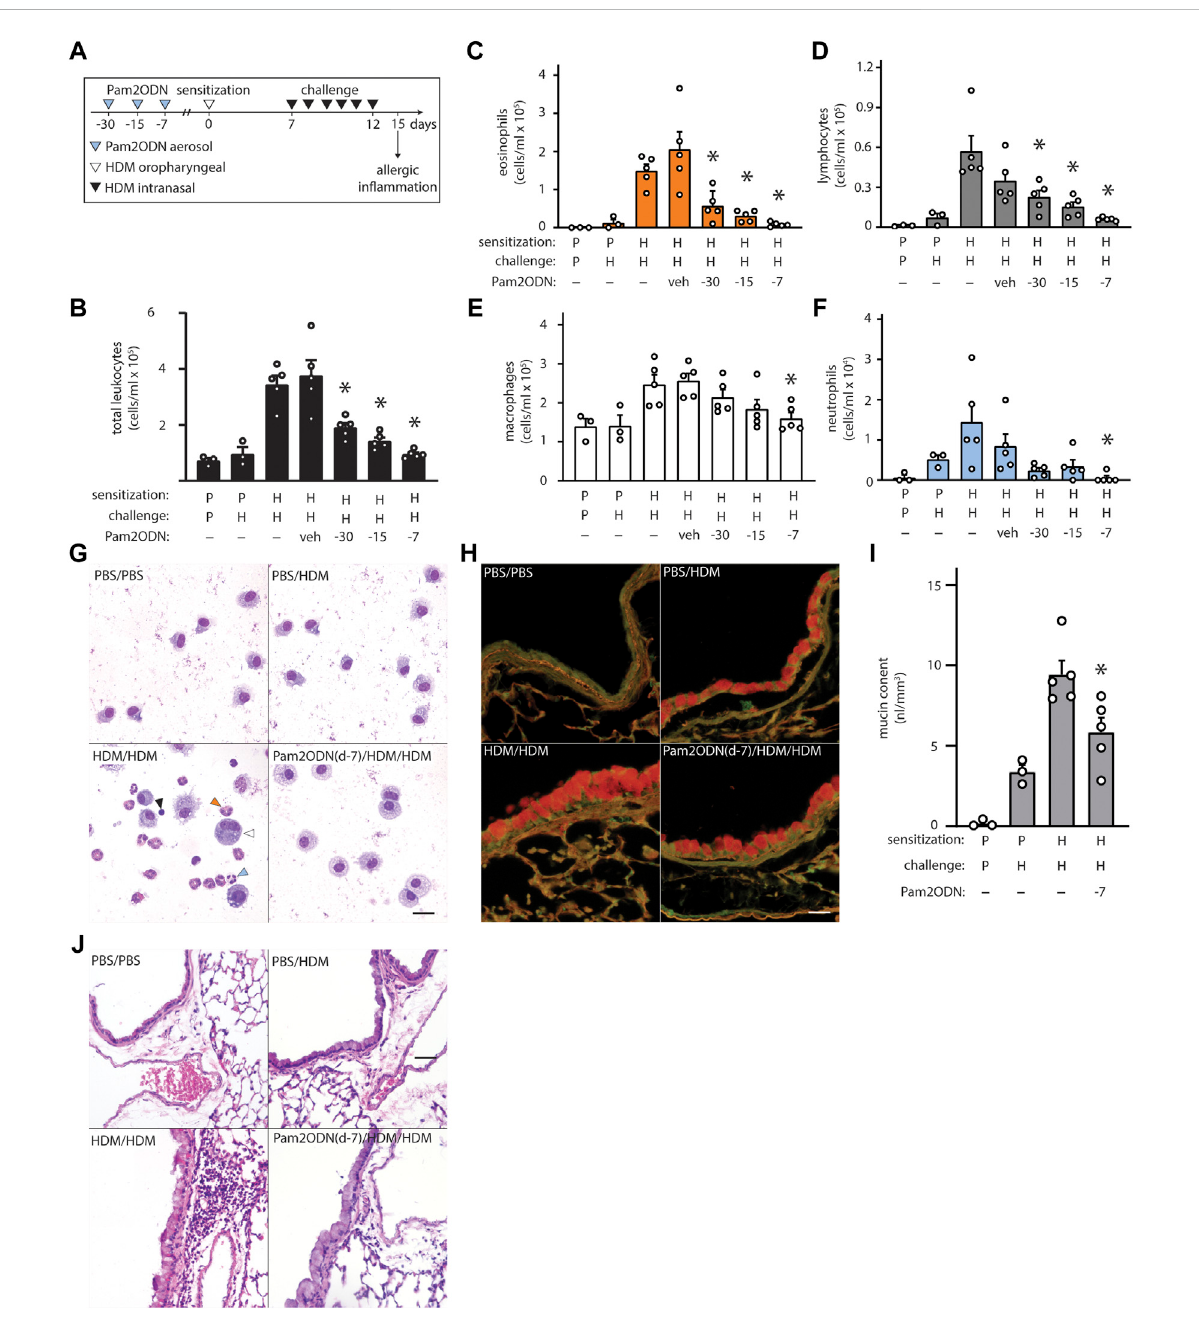
FIGURE 1 Exposure to Pam2-ODN attenuates allergic in fl ammation to HDM. (A) HDM experimental paradigm with a sensitization of 100 µg HDM and challenges of 10 µg HDM. In these studies, a single treatment of Pam2ODN was delivered by aerosol as described, 30-, 15-, and 7-days before initial HDM sensitization to naïve mice. (B) Leukocytes obtained by lung lavage were pelleted onto glass slides by centrifugation and stained with Wright- Giemsa. Scale bar = 20 μ m. (C – F) Quanti fi cation of leukocytes in lung lavage for (C) eosinophils, (D) lymphocytes, (E) macrophages, and (F) neutrophils (N = 3-5 mice). (G – H) Airways stained with H&E to demonstrate submucosal in fl ammation. Scale bar = 40 μ m (I) Airway epithelium stained with PAFS to demonstrate intracellular mucinin red.Scale bar =20 μ m. (J) Quanti fi cationof intracellular mucincontentbyimageanalysisof airway (N = 3-5 mice). Bars show mean +/- SEM. P* < 0.05 by one-way ANOVA with Dunnett ’ s test for multiple comparisons against [HDM/HDM] control. p = PBS. H =